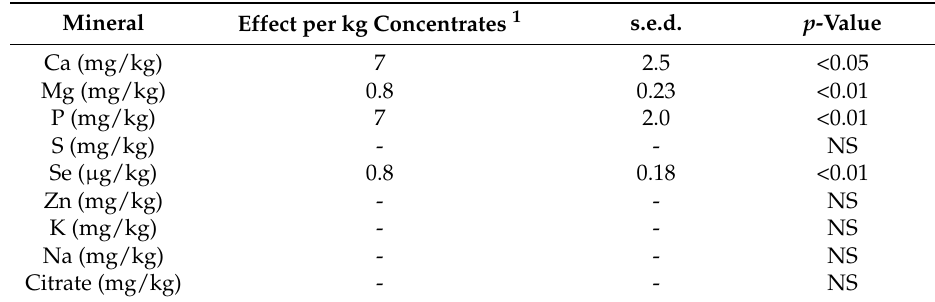
Table 5. Effect of dietary concentrate supplementation on milk mineral and citrate